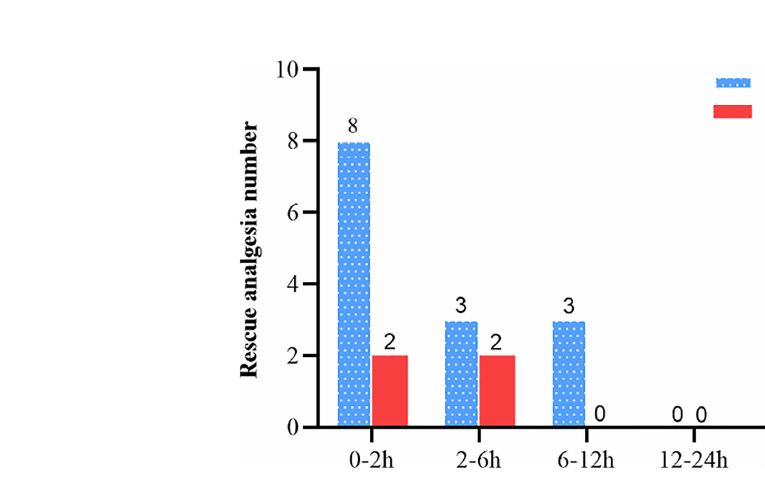
FIGURE 7 The number of people requiring additional rescue analgesia.